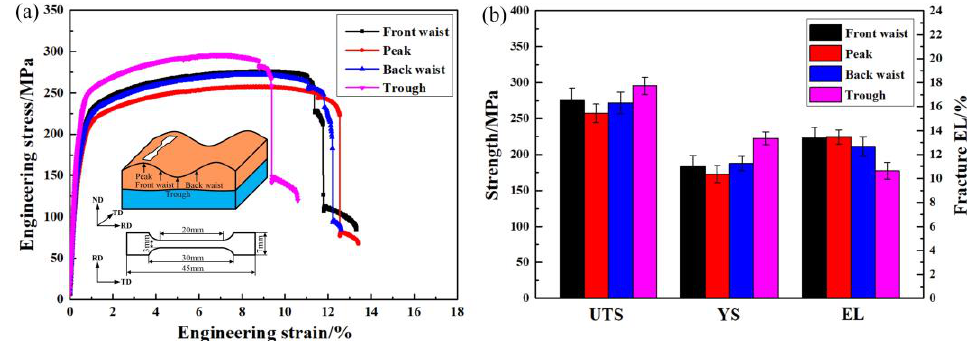
Figure 6. Transverse tensile properties of the corrugated Mg/Al clad sheet: ( a ) stress – strain curves; ( b ) properties histogram.